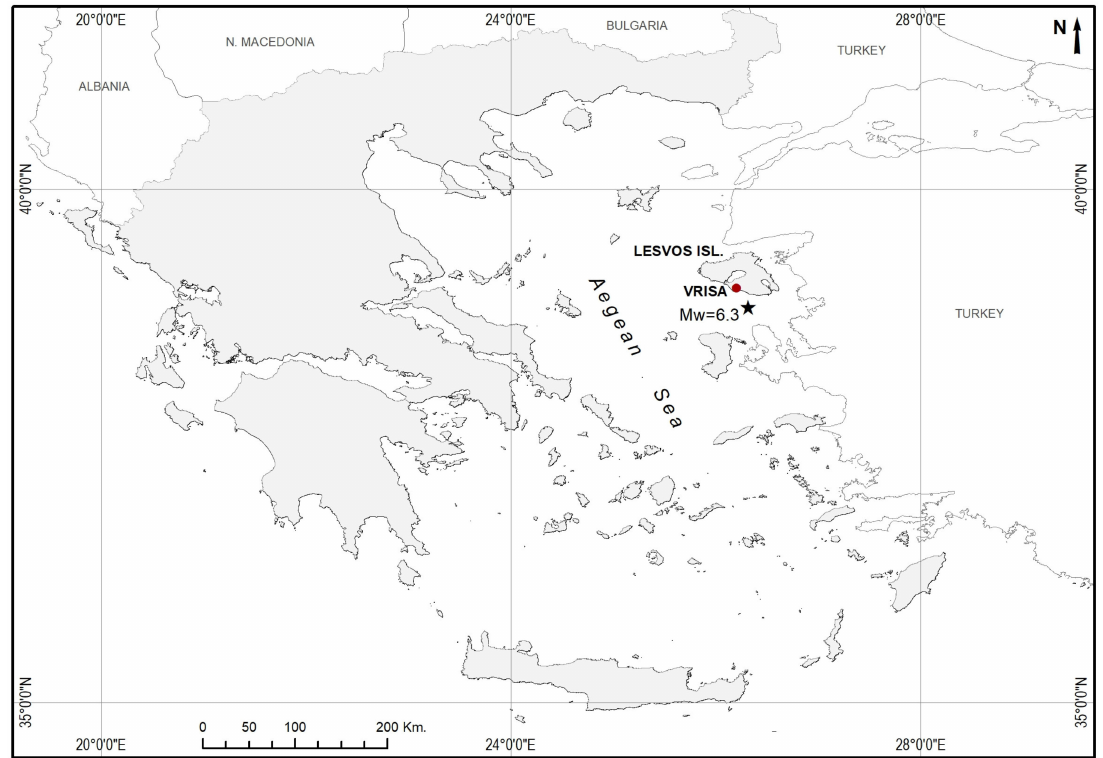
Figure 1. Simplified map of Greece presenting the location of Lesvos island, the Vrisa traditional settlement and the 12th of June 2017 (Mw 6.3) earthquake